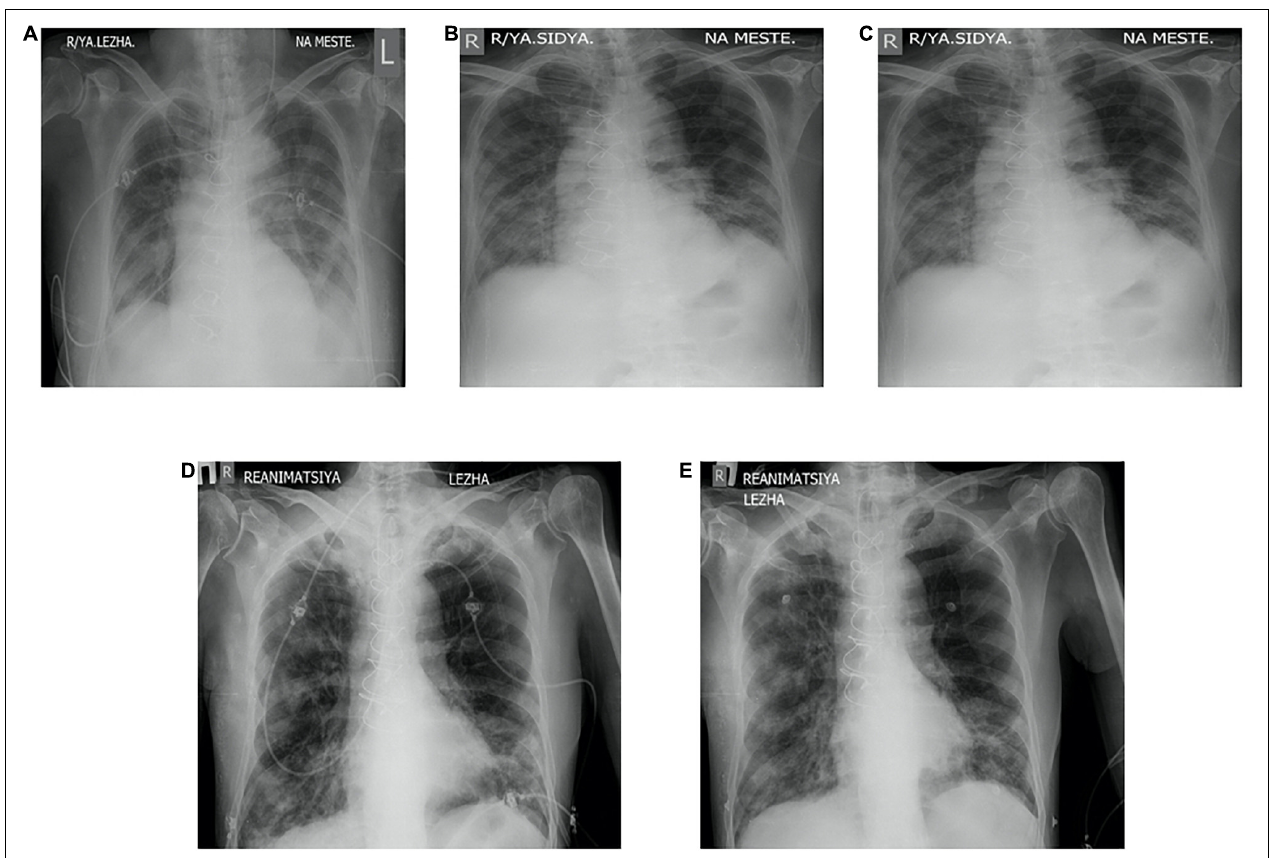
FIGURE 2 | Dynamics of X-ray after the application of VALT: CXR on the 1st day (A) , CXR after 18 sessions of VALT (B) , CXR on the 16th day (BiPAP: FiO 2 – 60%, f-18, I/E – 1/2, Pinsp – 25, PEEP – 14) (C) , CXR on the 25th day (BiPAP: FiO 2 -40%, f-18, I/E – 1/2, Pinsp-17, PEEP-12) (D) , CXR on the 32nd day (BiPAP: FiO 2 -40%, f-20, I/E – 1/2, Pins-20, PEEP 13) (E)